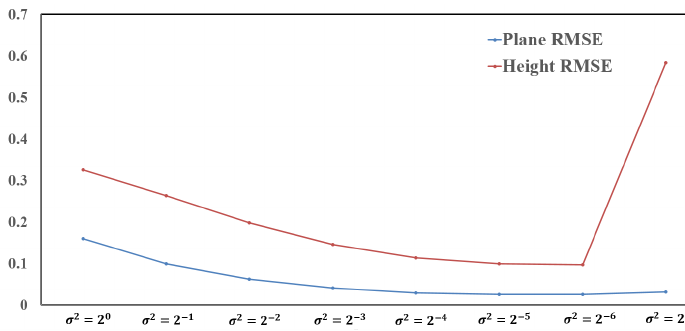
Figure 11. The RMSE as a function of the different parameters in the Gaussian kernel